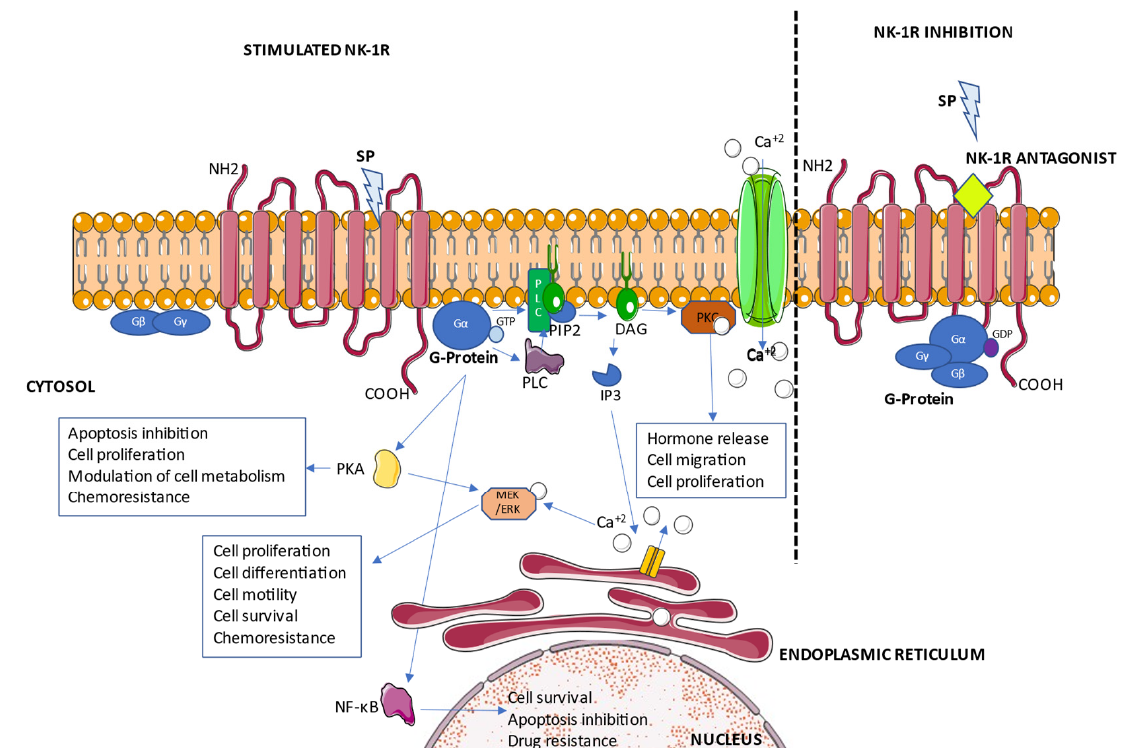
Figure 2. NK-1R signaling pathways related with chemoresistance.